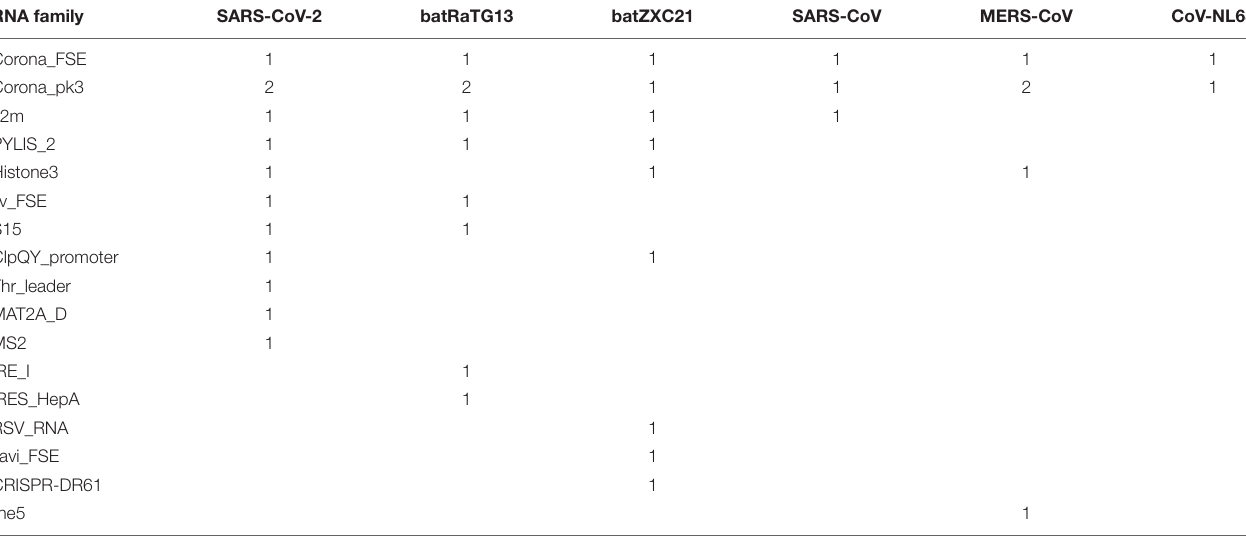
TABLE 4 | Comparative analysis of cis -acting RNA elements across different